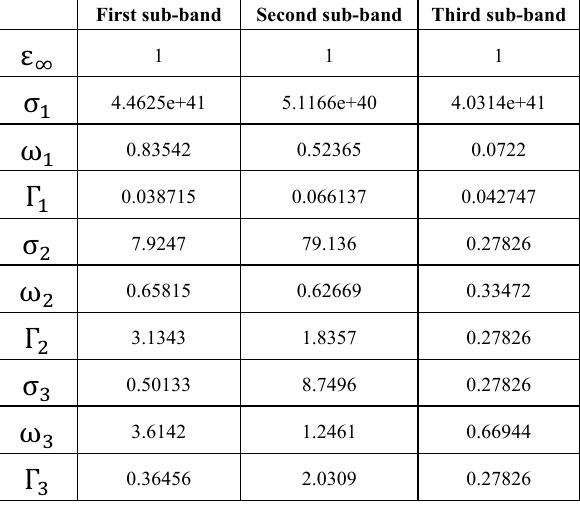
Figure 9. The mean error for the real and imaginary parts of Si permit- tivity through the entire wavelength of solar spectrum. TABLE II. LD FITTING PARAMETERS FOR S I IN THE THREE SUB - BANDS